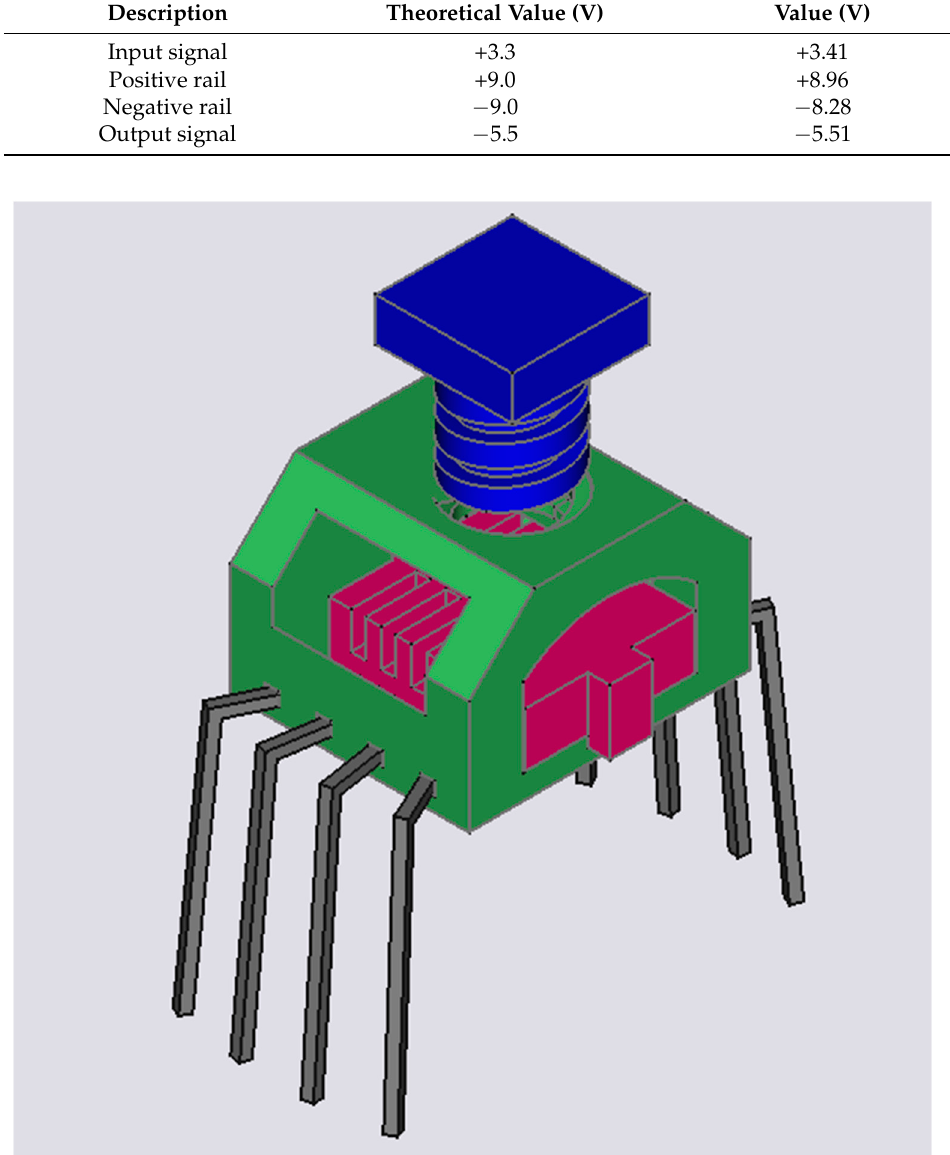
Figure 7. Orthographic view of the assembled CAD for the